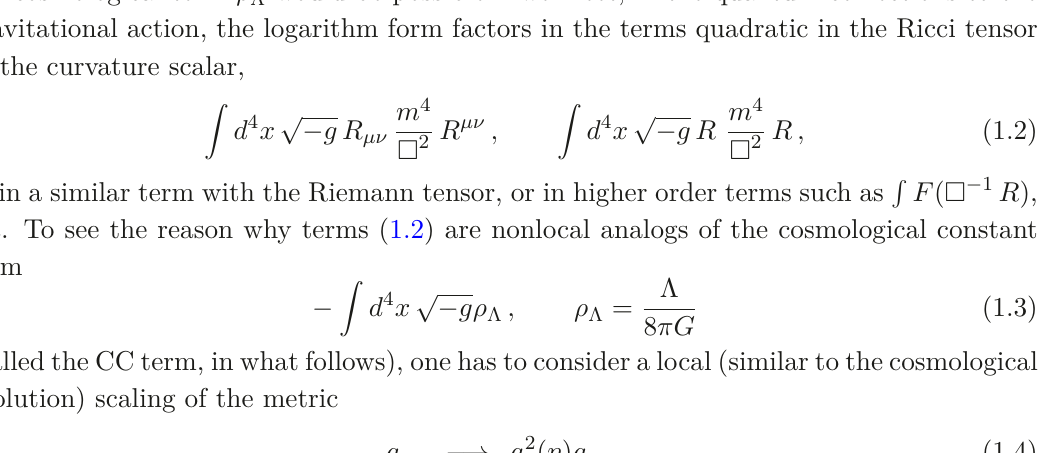
Figure 1 . Two diagrams of the one-loop correction to represented by thick lines. Diagram (a) gives a contribution to the nonlocal form factor, while diagram (b) contributes only to the local expression, i.e., divergences. Both plots are needed to provide a correspondence between logarithmic divergences and the logarithmic UV limit for the form factors